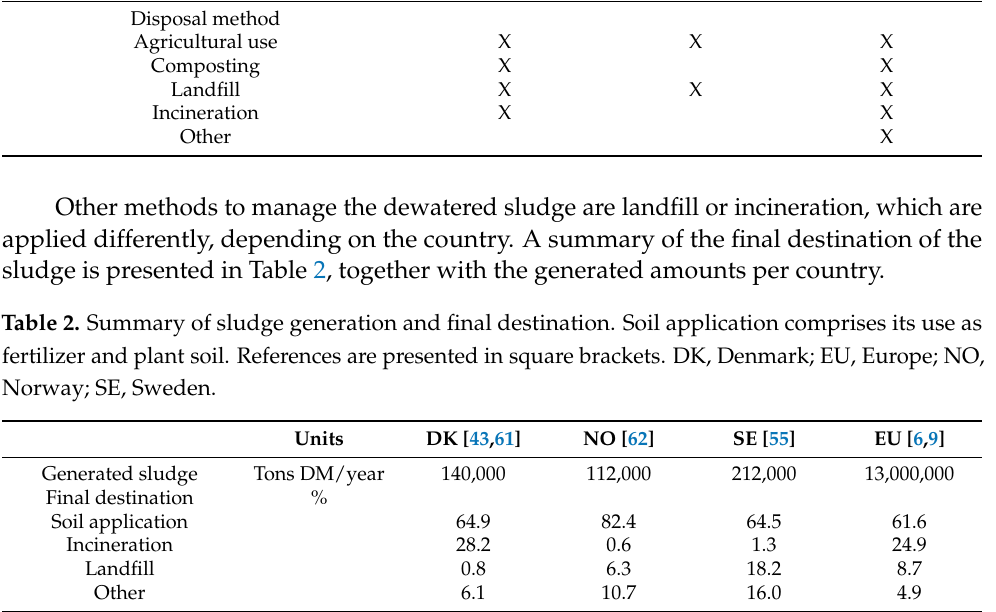
Table 1. Summary of sludge treatment and disposal methods in Scandinavian countries. References are presented in square brackets. AD: Anaerobic digestion; DK, Denmark; NO, Norway; SE, Sweden. DK [43] NO [51] SE [33] Treatment method Dewatering X AD + Dewatering X X X Mineralization bed X AD + Mineralization bed X Dewatering + Lime addition X X Thermal treatment + AD X Disposal method Agricultural use X X X Composting X X Landfill X X X Incineration X X Other X